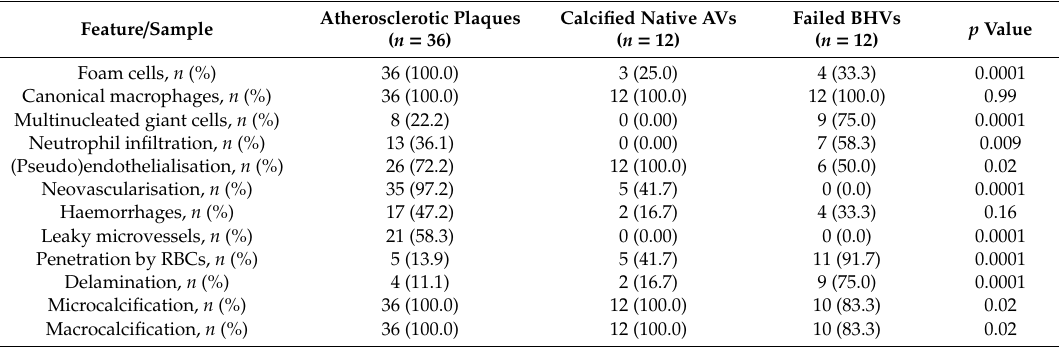
Atherosclerotic Plaques Calcified Native AVs Failed BHVs ( n = 36) ( n = 12) ( n = 12)